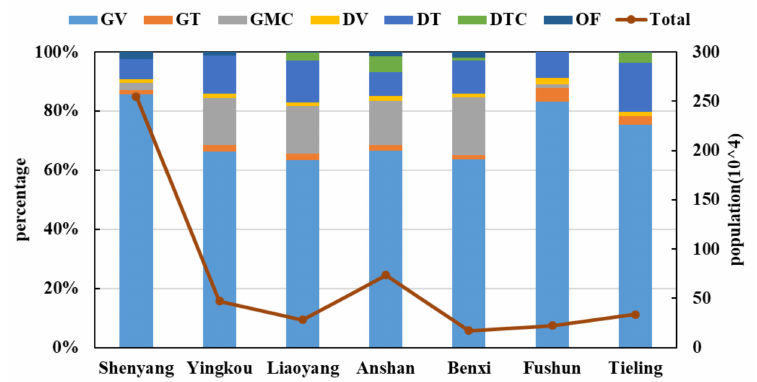
Figure 2. Total vehicle quantities and distribution by type in the CLUA region during